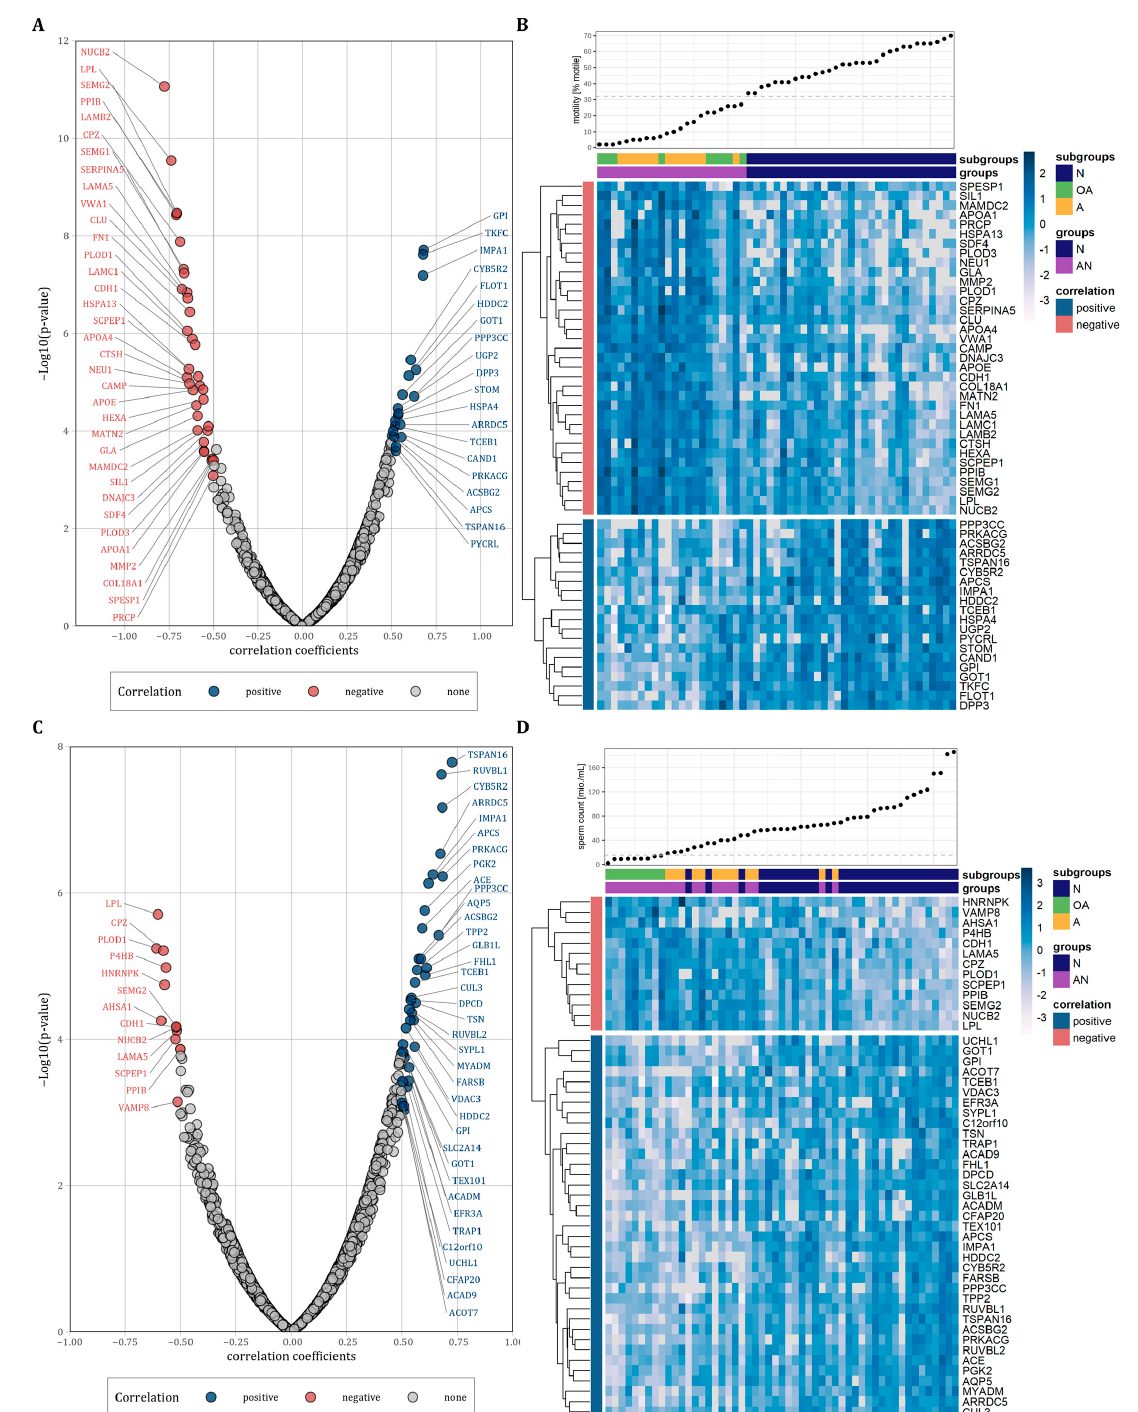
Figure 3. ( A , C ): Volcano plots of correlations between protein abundance levels of all identified proteins and sperm motility or sperm count plotted against the − log10 p -value, respectively. Correlated proteins were highlighted by color (r > 0.5 and r < − 0.5). ( B , D ): Heatmaps representing vertically hierarchical clustering of the abundance levels of proteins that were correlated with sperm motility or sperm count, respectively (r > 0.5 and r < − 0.5). Horizontally, the proteins were sorted by increasing sperm motility or sperm count, respectively. The colour of rectangles represents z-scored protein abundance levels (white, lower abundant proteins; dark blue, higher abundant proteins; light blue, no